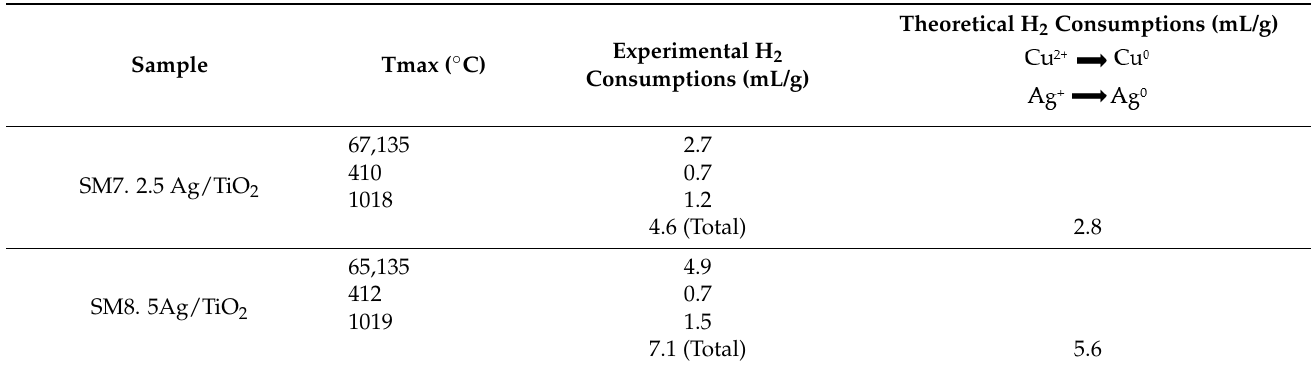
Figure 3. H 2 -TPR profiles of the calcined solids: ( a ) Cu-based, ( b ) Cu-Ag- and Ag-based materials. Table 2. Cont. Table 2. Reduction temperatures and H 2 consumption